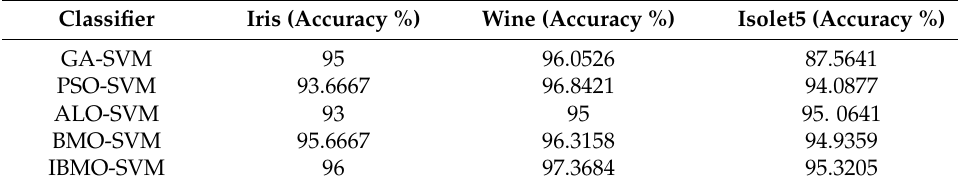
Table 5. Comparison of test accuracy results of classifiers.